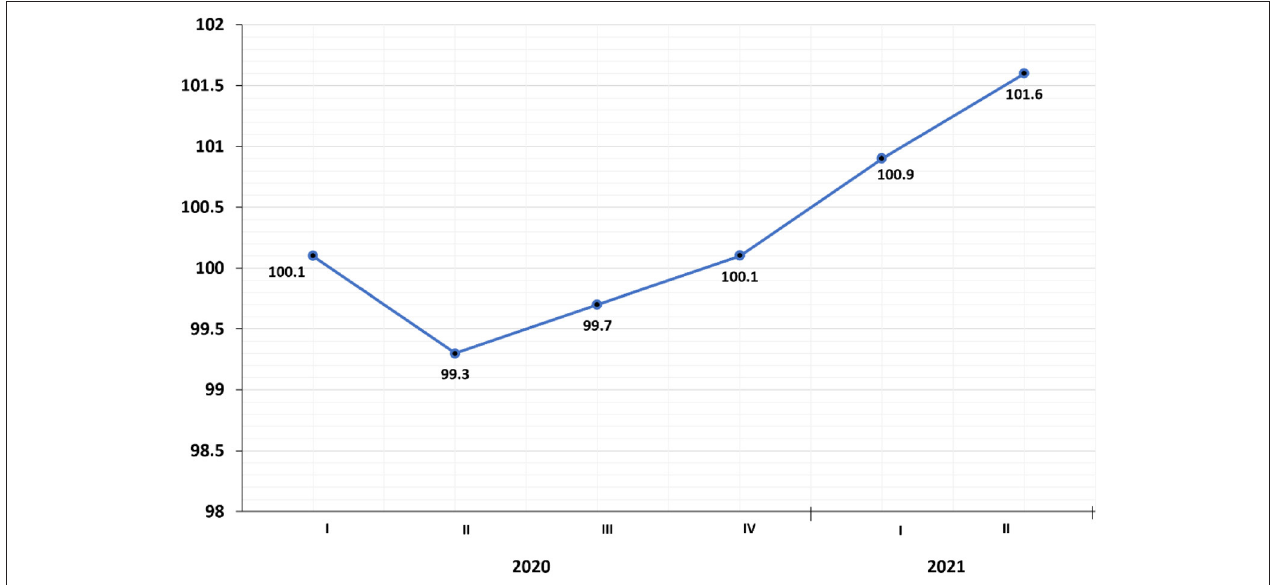
FIGURE 3 | Consumer Price Index (CPI) for food in Singapore, 2020–2021. Source: Singapore Department of Statistics, Ministry of Trade and Industry (MTI), Statistical Appendix, Consumer Price Index. https://www.mti.gov.sg/-/media/MTI/Resources/Economic-Survey-of-Singapore/2021/Economic-Survey-of-Singapore- Second-Quarter-2021/A3_1_2Q21_.xlsx.